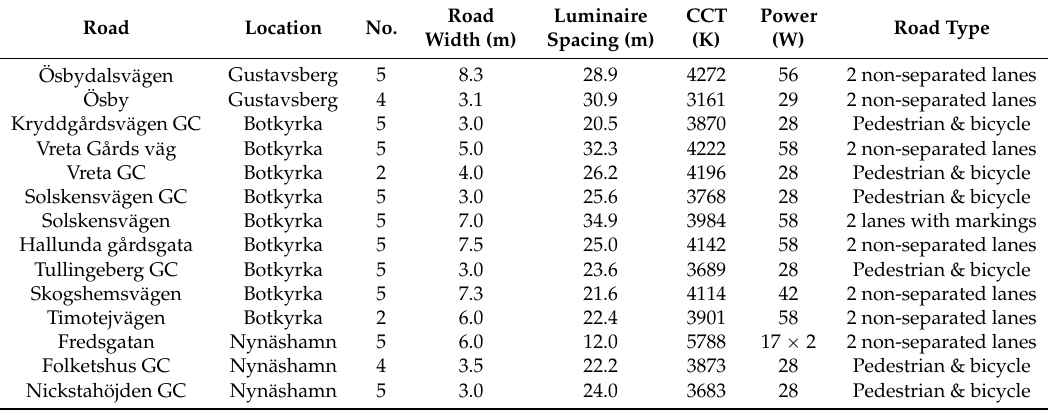
Table 1. Road name, location, number of measurements on each road (No.), road width (m), luminaire spacing (m), correlated colour temperature (CCT, K), installed power (W) and road type. GC = pedestrian and bicycle